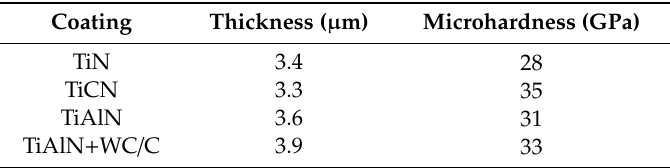
Table 1. Main parameters of the coatings under study.